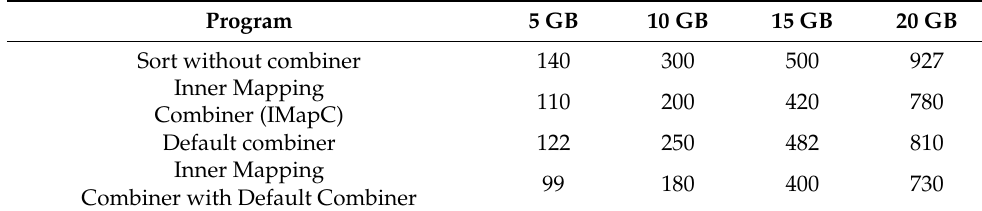
Table 3. Performance improvement of IMapC with the Default Combiner on running the Sort program in Standard Hadoop.